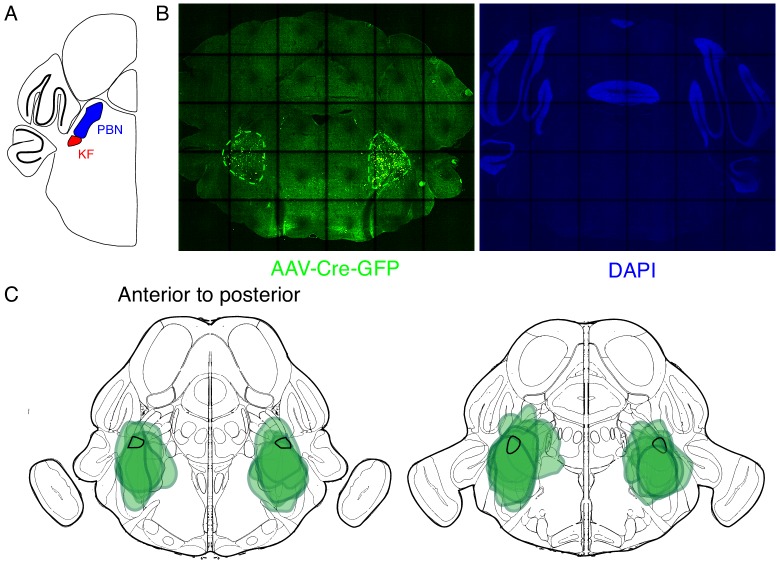
Expression of GFP protein from AAV-Cre-GFP after bilateral PBN/KF injection.(A) Schematic of a coronal section through the brainstem at the position of the PBN/KF. The PBN/KF is in the dorsal brainstem near the cerebellar peduncle. Half the brain is represented here. (B) GFP protein (green) expression in a 25 µM coronal section of the brainstem from an adult Oprm1f/f mouse injected bilaterally with AAV-Cre-GFP into the PBN/KF. This anatomical localization of GFP validates the specific targeting of AAV-Cre, and thus Oprm1 deletion, to the PBN/KF. (C) Schematic of two serial coronal sections of the mouse brain from most anterior (left) to posterior (right) that cover the PBN/KF injection sites visualized by AAV-Cre-GFP expression (example in B). The extend of GFP expression for each injection site is highlighted by the green annotations in C), and the representative example in B) (green dashed line). Note that overlap of all injection sites contains the KF (black solid line).